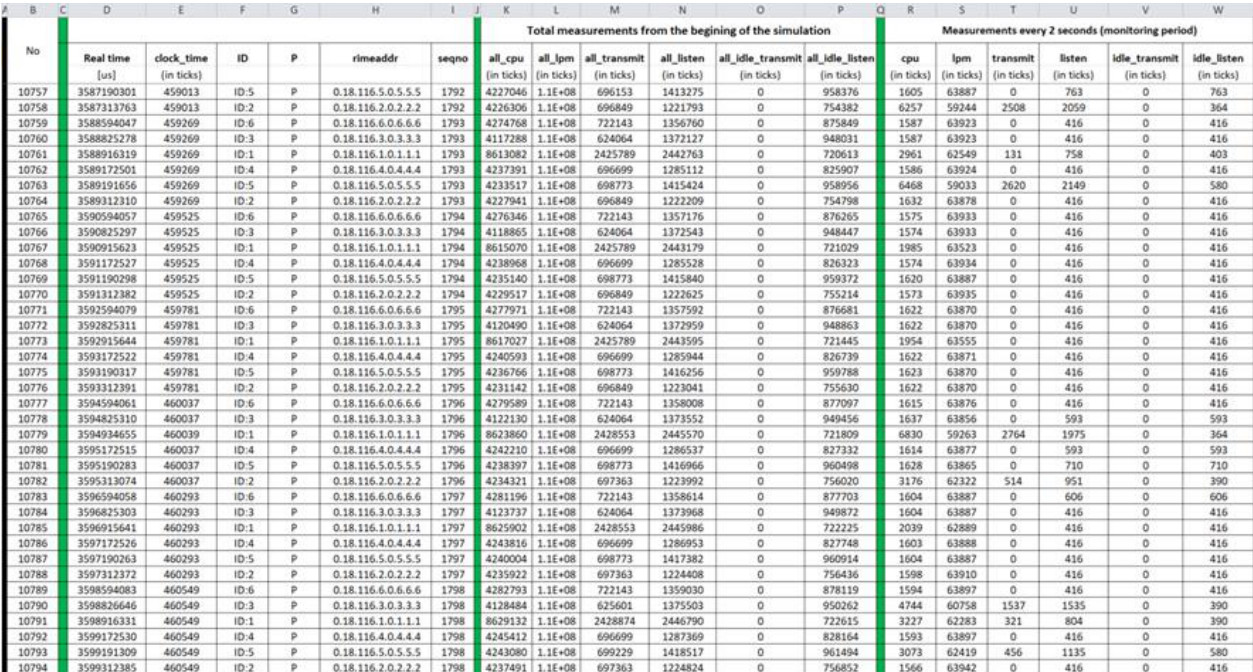
Figure 12. Benign “pwrtrace.csv”— 10,757 to 10,794 records.